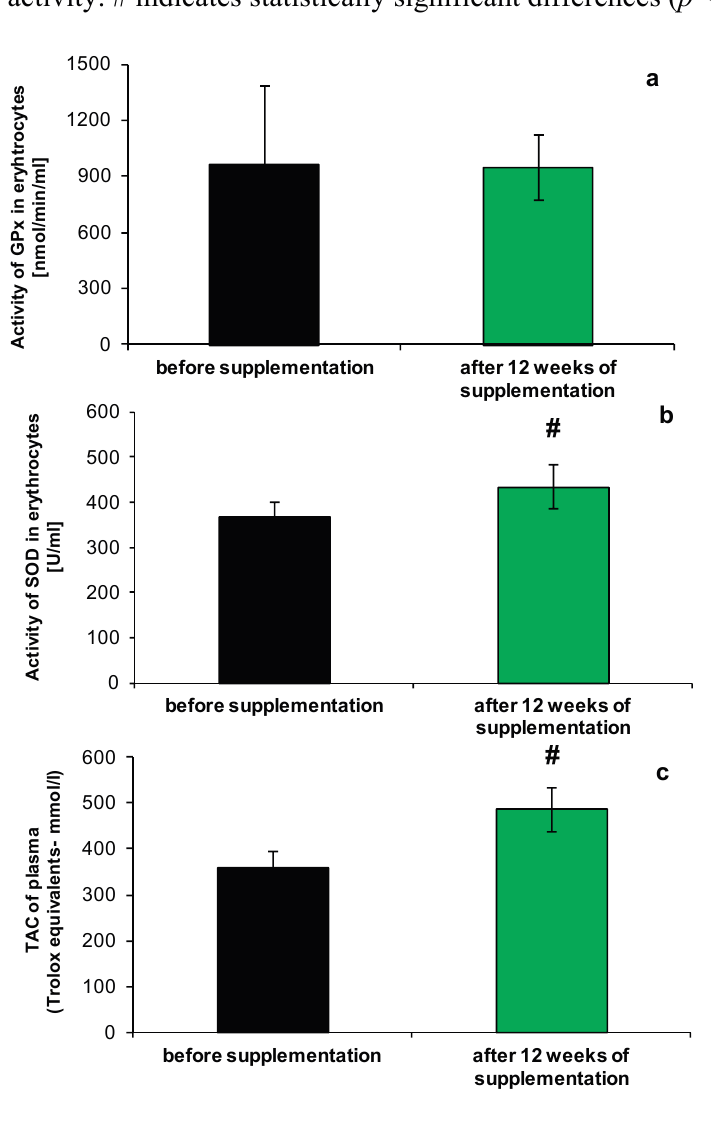
Figure 1. Changes in antioxidative potential of blood before and after NucleVital ® Q10 Complex supplementation: ( a ) total antioxidant capacity of plasma (FRAP assay); ( b ) SOD activity; ( c ) GPx activity. # indicates statistically significant differences ( p <